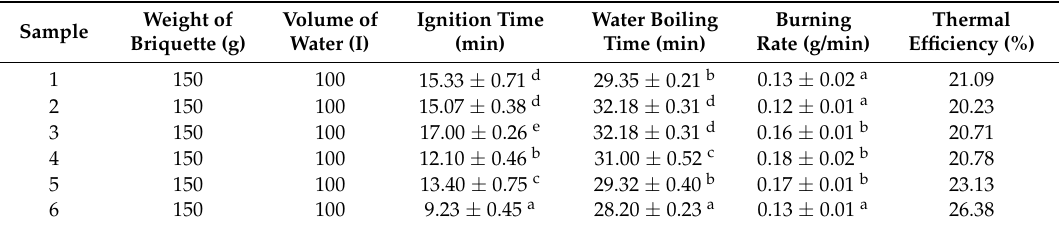
Table 7. Energy Evaluation Analysis of Briquettes Samples